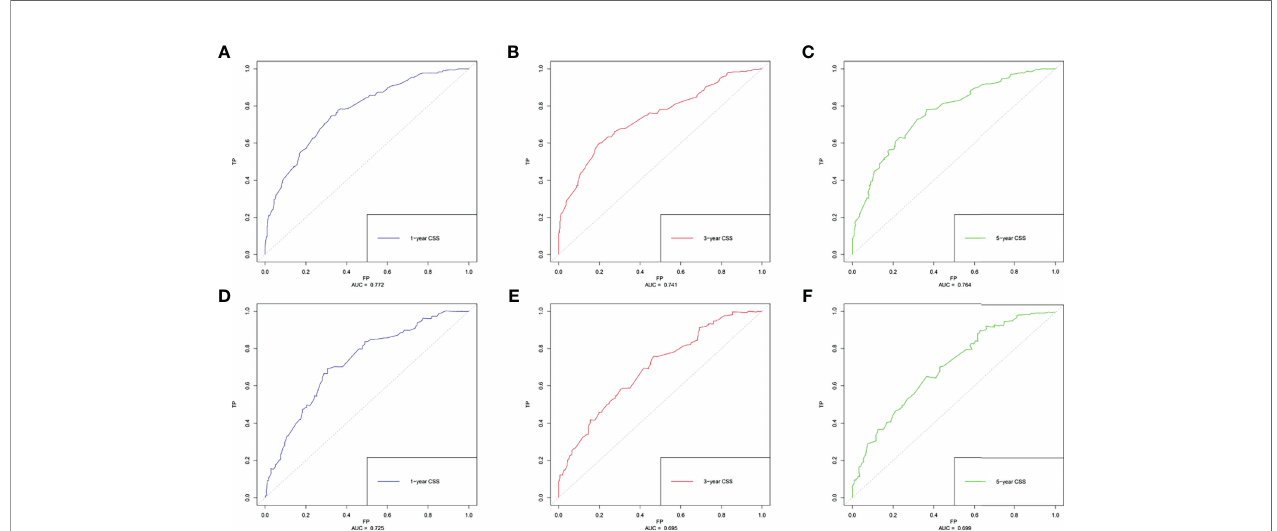
FIGURE 4 | The receiver operating characteristics (ROC) curve and area under the ROC curve (AUC). (A) Predicting 1-year CSS in the training cohort; (B) predicting 3-year CSS in the training cohort; (C) predicting 5-year CSS in the training cohort; (D) predicting 1-year CSS in the validation cohort; (E) predicting 3-year CSS in the validation cohort; (F) predicting 5-year CSS in the validation cohort.